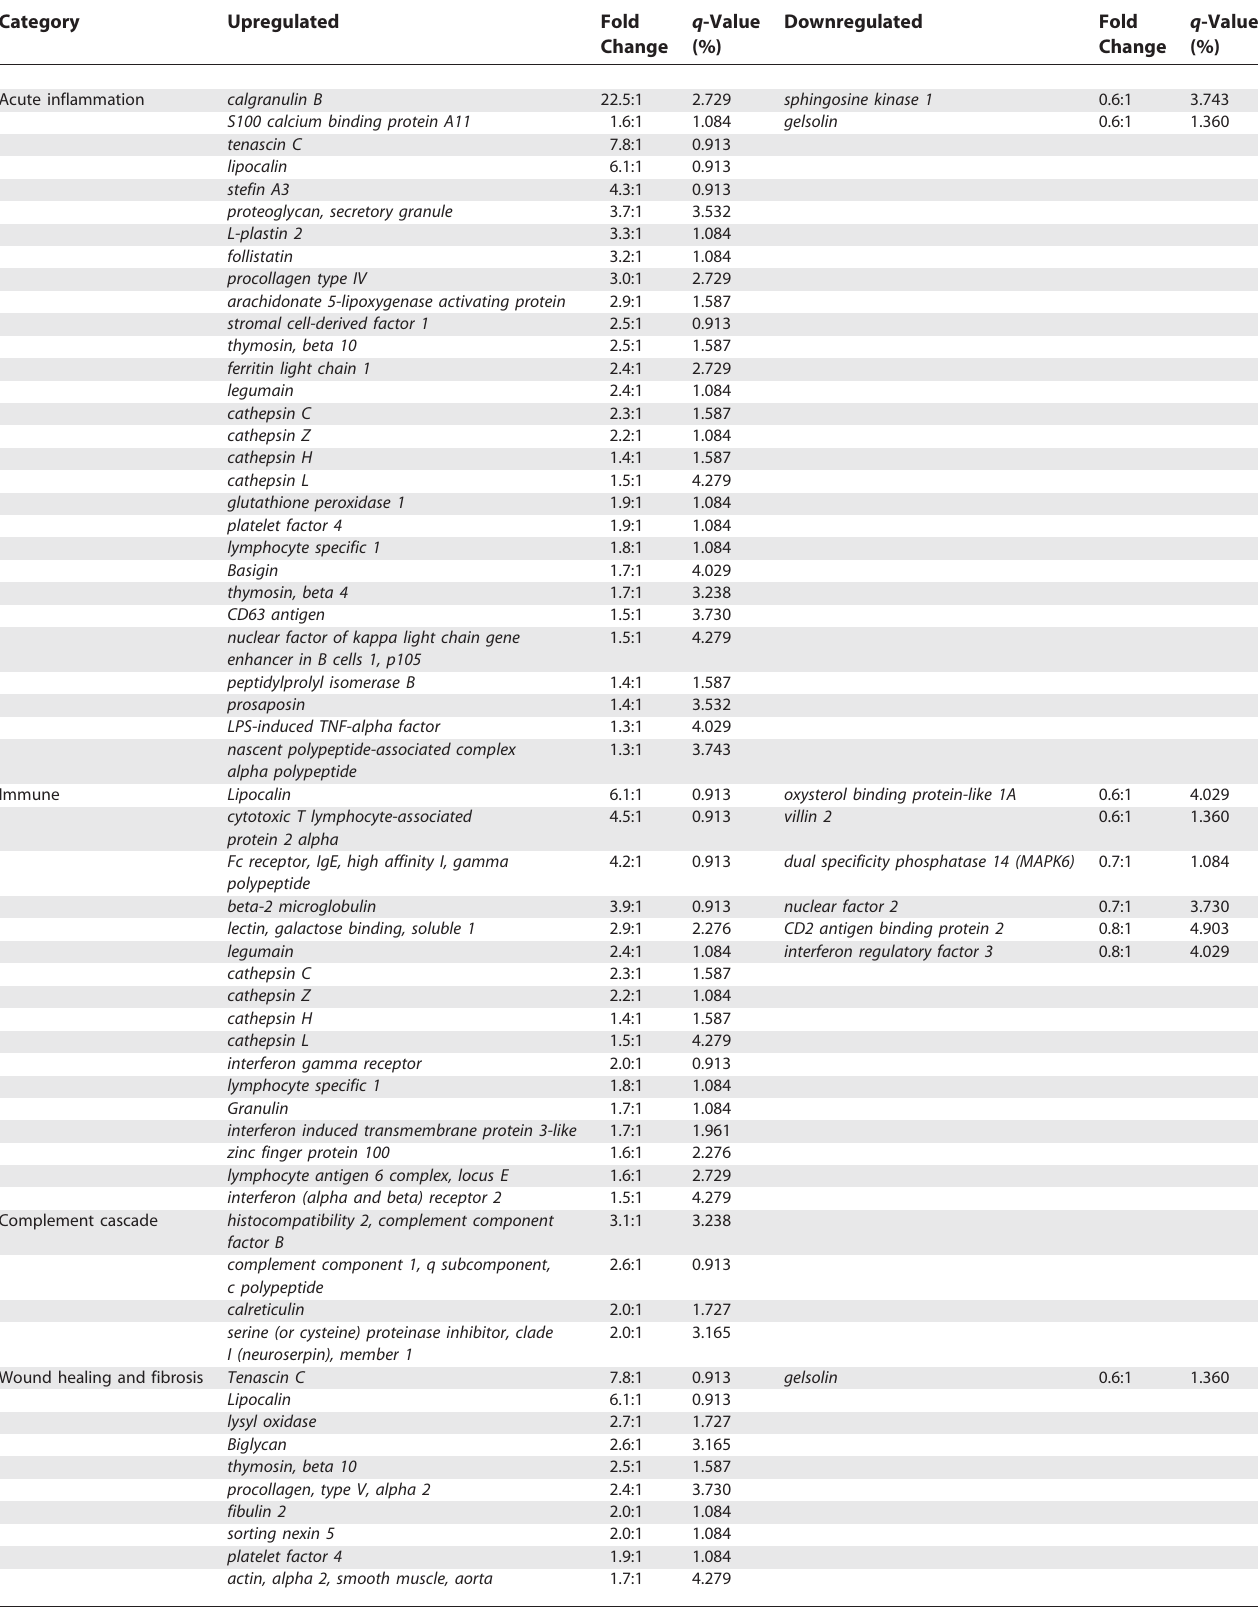
Table 7. Functional Gene Expression Analysis in Experimental Lymphedema